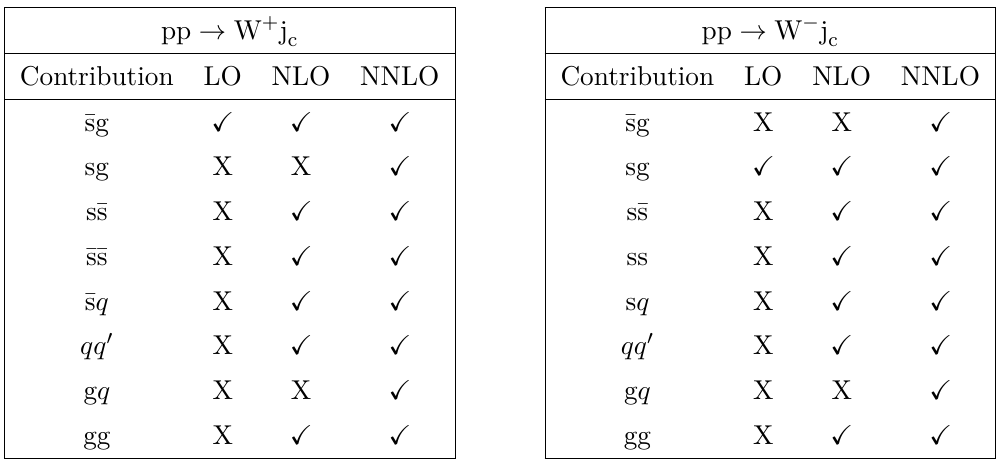
Table 1. List of initial-state contributions for pp → W + j LO, NLO, and NNLO QCD. Any (anti-)quark that is not a (anti-)strange quark is denoted by q or q 0 . Here V = 0 is cd